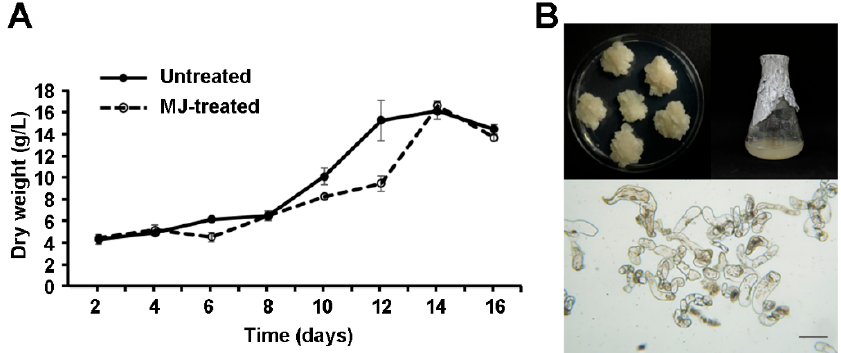
Figure 2. Growth curve analyses of the S. flavescens cell cultures. ( A ) The growth of cells treated with or without methyl jasmonate (MJ) in 125 mL flask cultures containing 25 mL of MS1B2P liquid medium was measured at different time points. Data are the mean of three independent replicates ± SD. ( B ) The morphology of S. flavescens callus and cell suspension cultures. The cells were observed under an inverted light microscope (Carl Zeiss, Germany) equipped with a camera. Scale bar indicates 100 μ m.